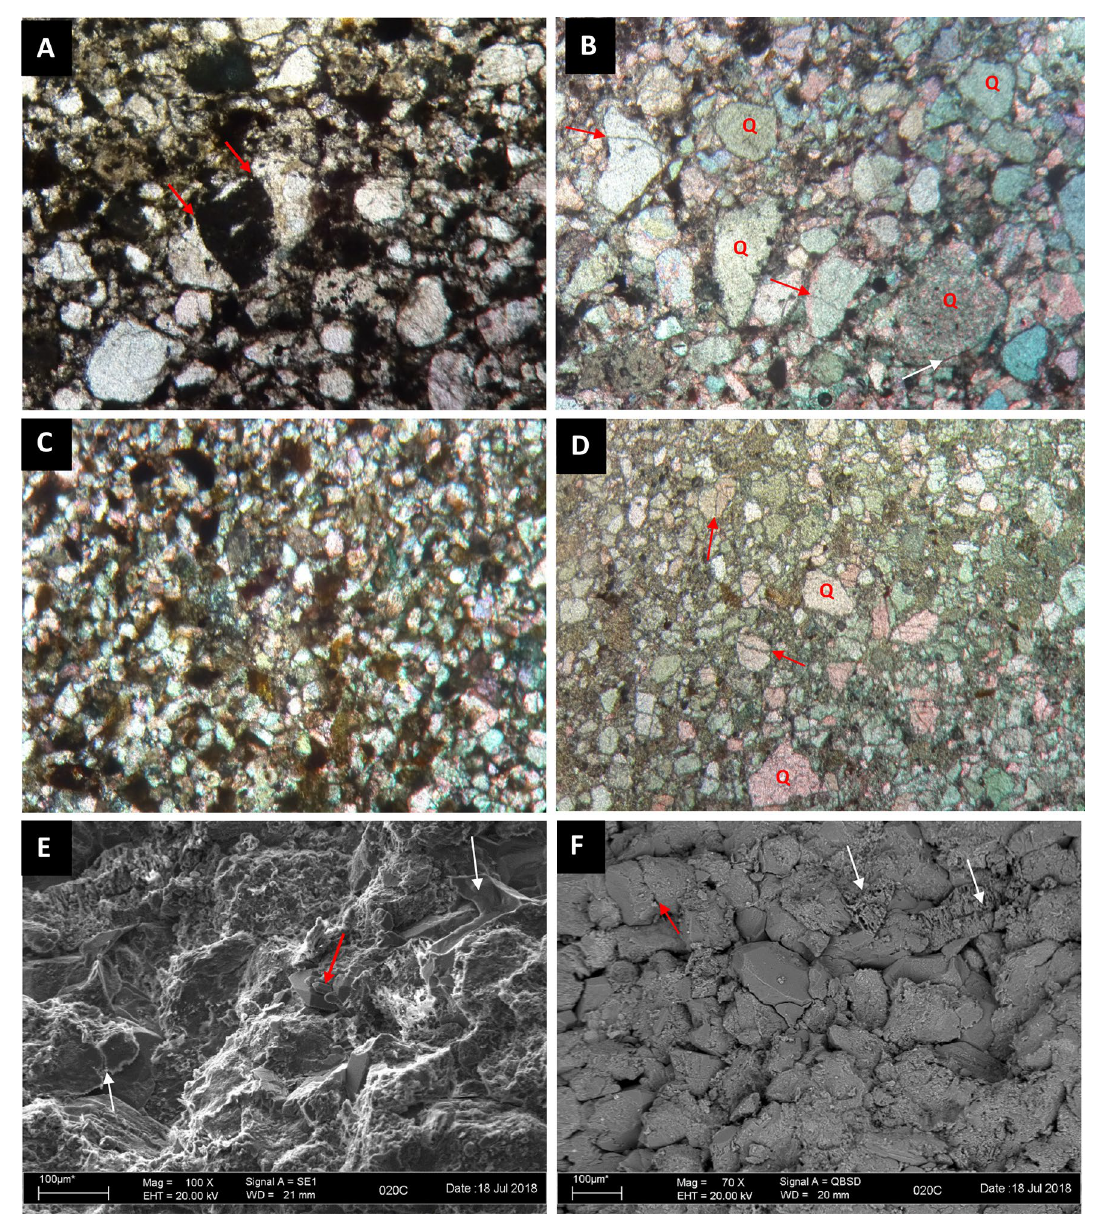
Fig. 12 Thin-section and SEM images showing diagenetic signatures in representative reservoir sandstones of the central onshore Sarawak: a long grain contact indicated by red arrows, b broken quartz grains shown by red arrow and quartz overgrowth indicated by white arrows, c brown-to-dark reddish hematitic cement in fine grained reservoir, d